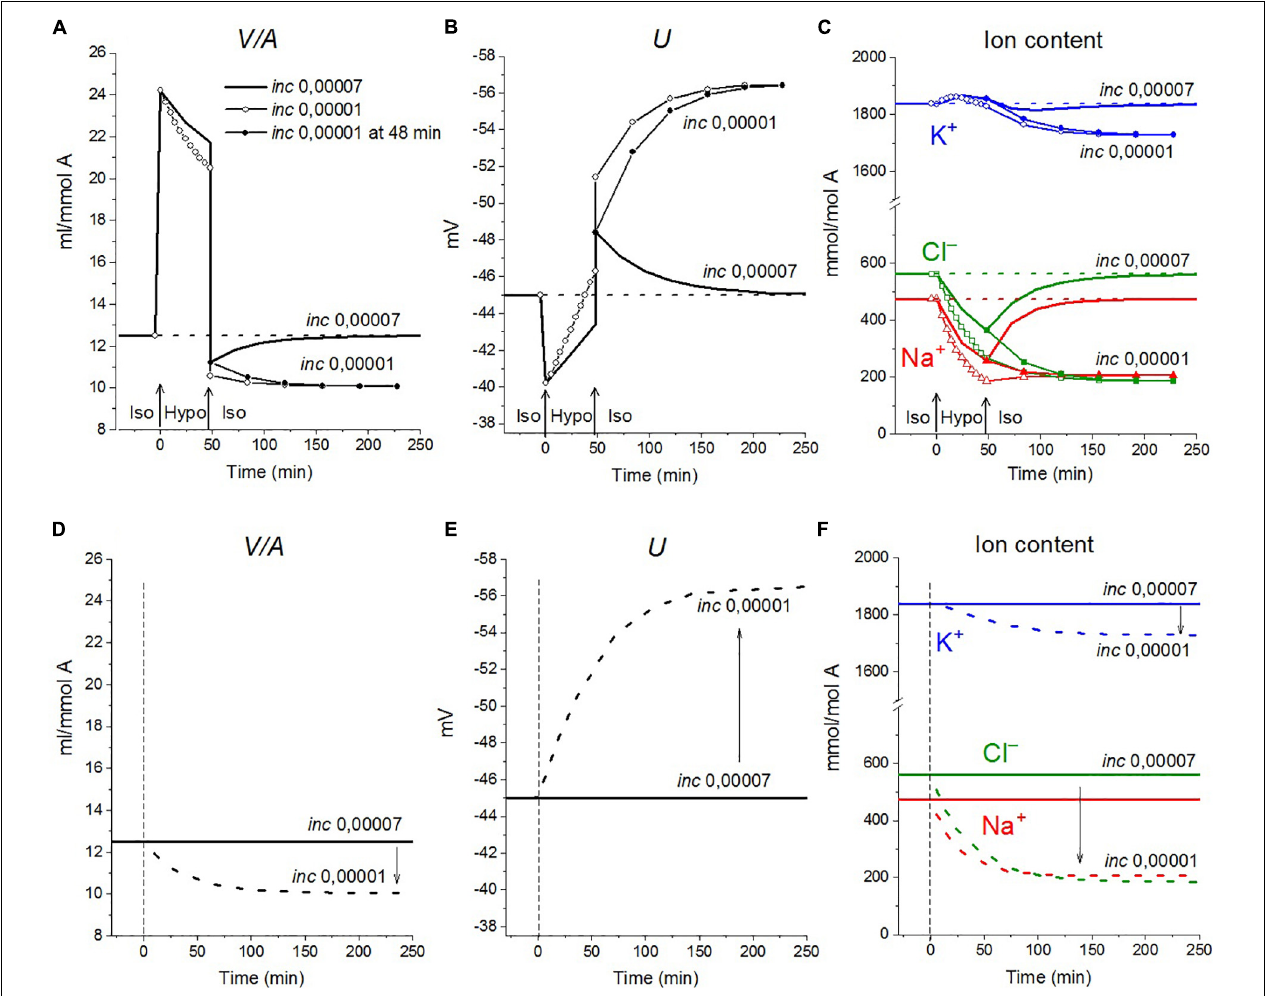
FIGURE 7 | The effect of NC rate constant on the rearrangement of ionic homeostasis during the Iso-Hypo-Iso transitions (A–C) and in a normal 310 mOsm medium without changes in external osmolarity (D–F) , calculated for a system with a full set of cotransporters (NC + KC + NKCC). Changes in the inc coefficient are displayed on the graphs. (A–C) inc was changed either simultaneously with the transition to a hypotonic medium (at t = 0) or upon a return to a normal isotonic (at t = 48 min). Other parameters remain